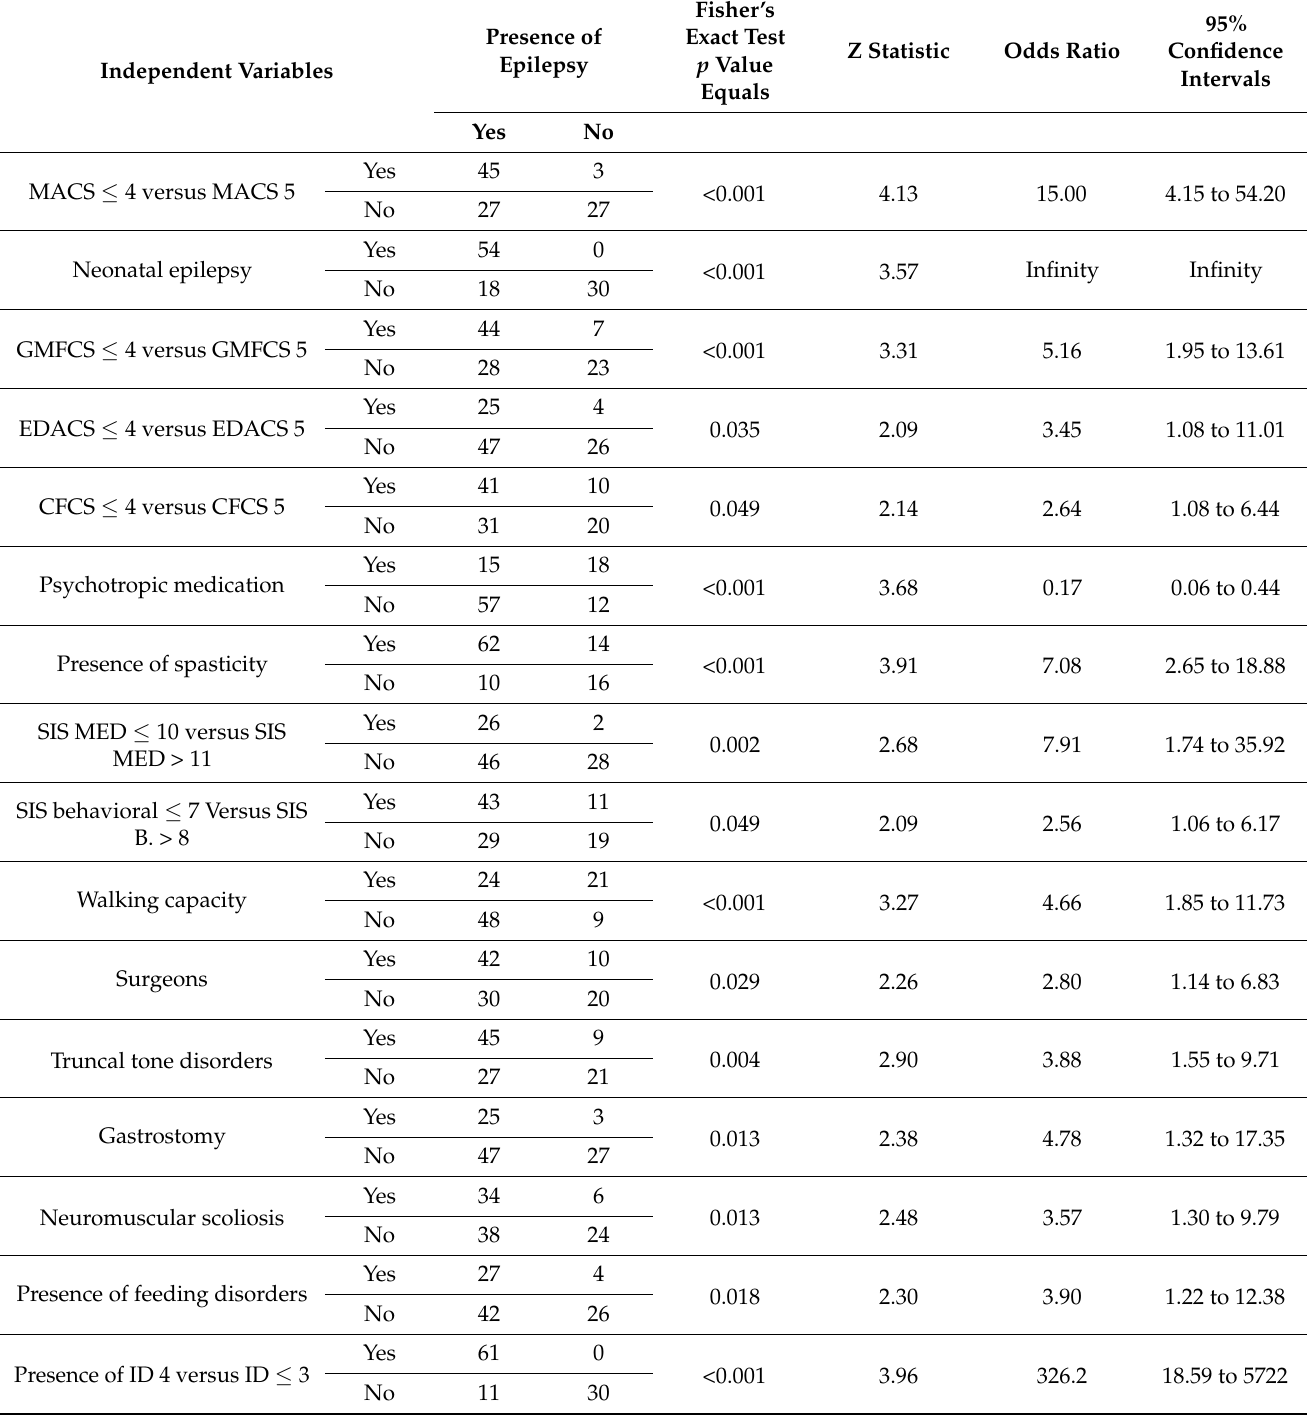
Table 2. Contingency table and Fisher’s exact test comparing subjects with and without epilepsy. Gross Motor Function Classification System (GMFCS), Manual Ability Classification System [MACS], Communication Function Classification System (CFCS), Support Intensity Scale (SIS), Medical and Be- havioral and Intellectual Disability (ID), Eating and Drinking Ability Classification System (EDACS). Fisher’s 95% Exact Test Presence of Odds Ratio Confidence Epilepsy